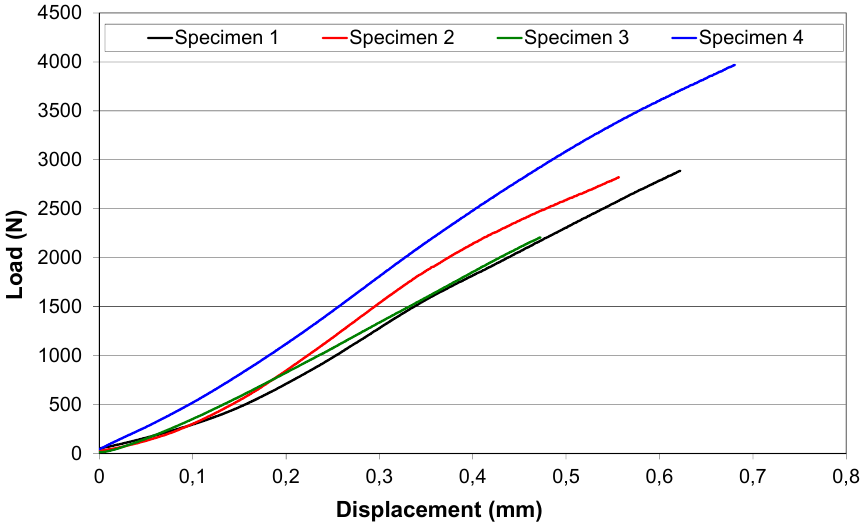
Figure 5: Load versus displacement curves obtained for the four specimens.